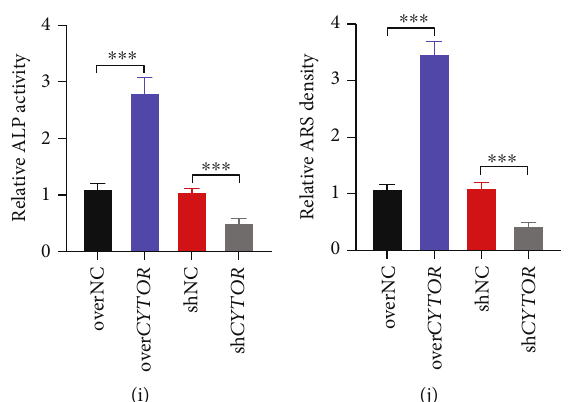
Figure 1: Long noncoding RNA CYTOR is mainly expressed in the cytoplasm of PDLSCs and facilitates the osteogenic di ff erentiation of PDLSCs. (a) The expression and subcellular location of CYTOR in PDLSCs was observed by RNA fl uorescence in situ hybridization. U6 was a reference gene which mainly expressed in the nuclei. Probe against U6 as a positive control. Cell nuclei were counterstained with DAPI (blue). Scale bar, 20 μ m. (b) Relative level of CYTOR at indicated timepoints during osteogenic di ff erentiation of PDLSCs were detected by qRT-PCR. (c) RNA level of CYTOR of PDLSCs treated with lentiviruses as indicated was measured by qRT-PCR. (d) The GFP signals were detected by inverted fl uorescence microscope. (e) The mRNAs levels of osteogenic-related markers were determined by qRT-PCR. (f) The protein levels of osteogenic-related markers were measured by western blot. (g, i) The ALP activity was determined by ALP staining (g) and ALP measurement (i). (h) The mineralized nodules were assessed by Alizarin red staining. (j) Semiquanti fi cation of mineralized nodules. ∗ p < 0 : 05 , ∗∗ p < 0 : 01 , and ∗∗∗ p < 0 : 001 , compared with the control group as